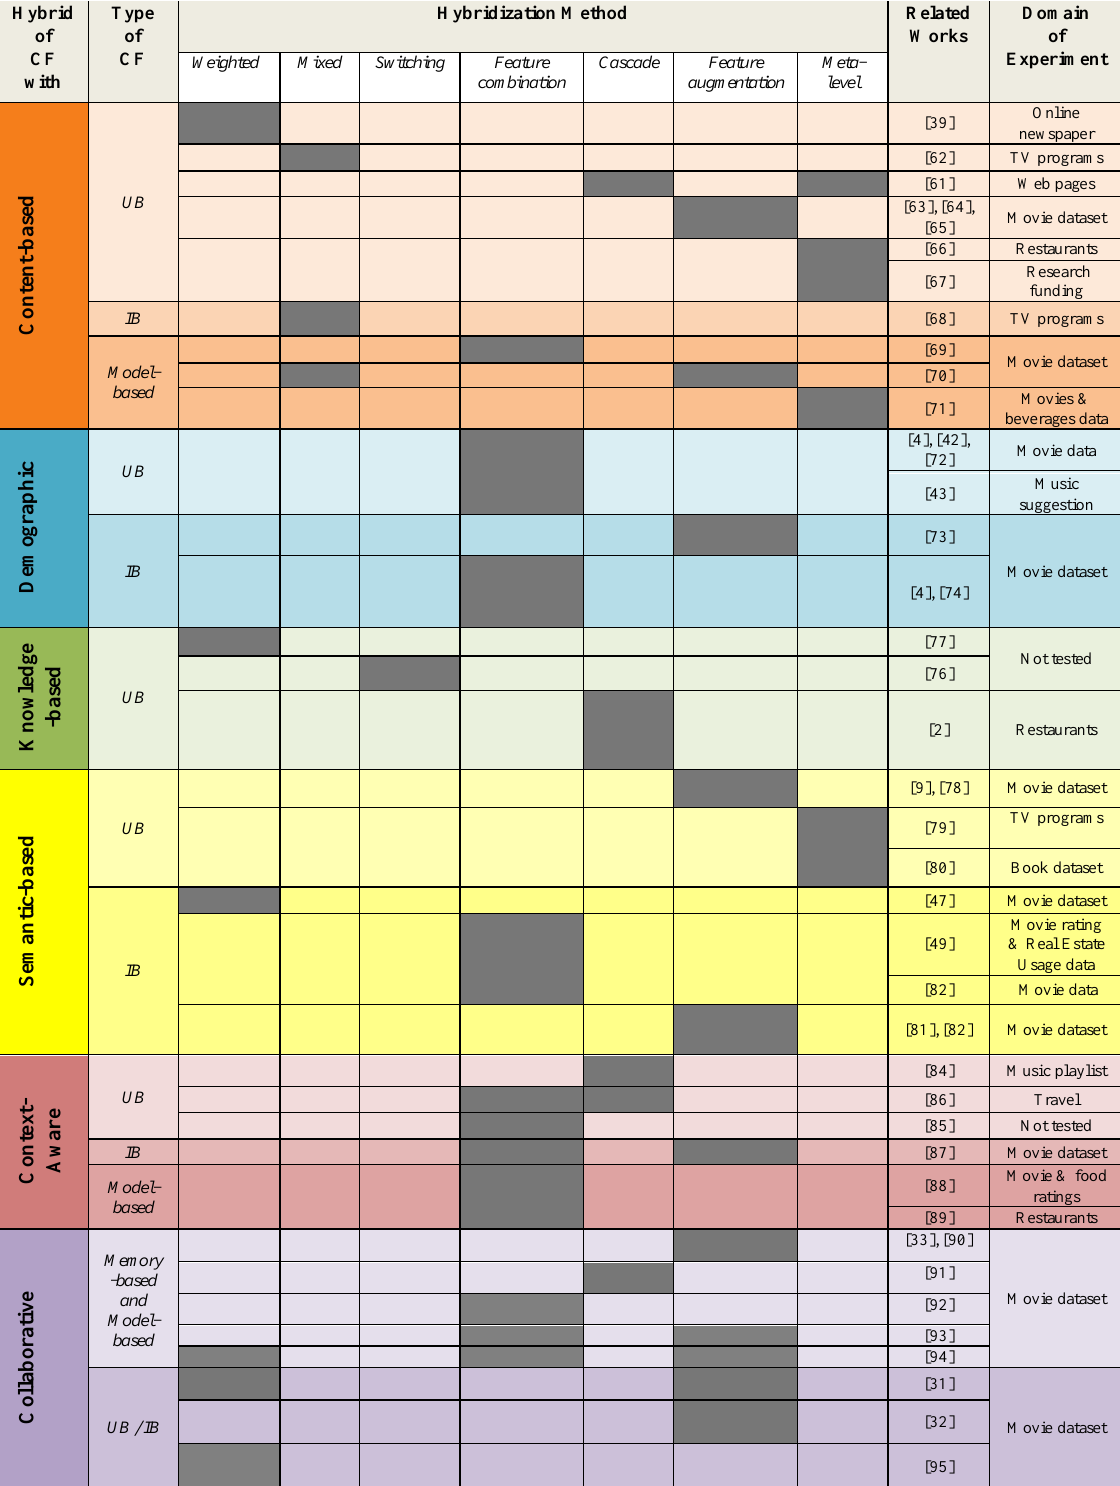
Table 1. Classification of hybrid CF